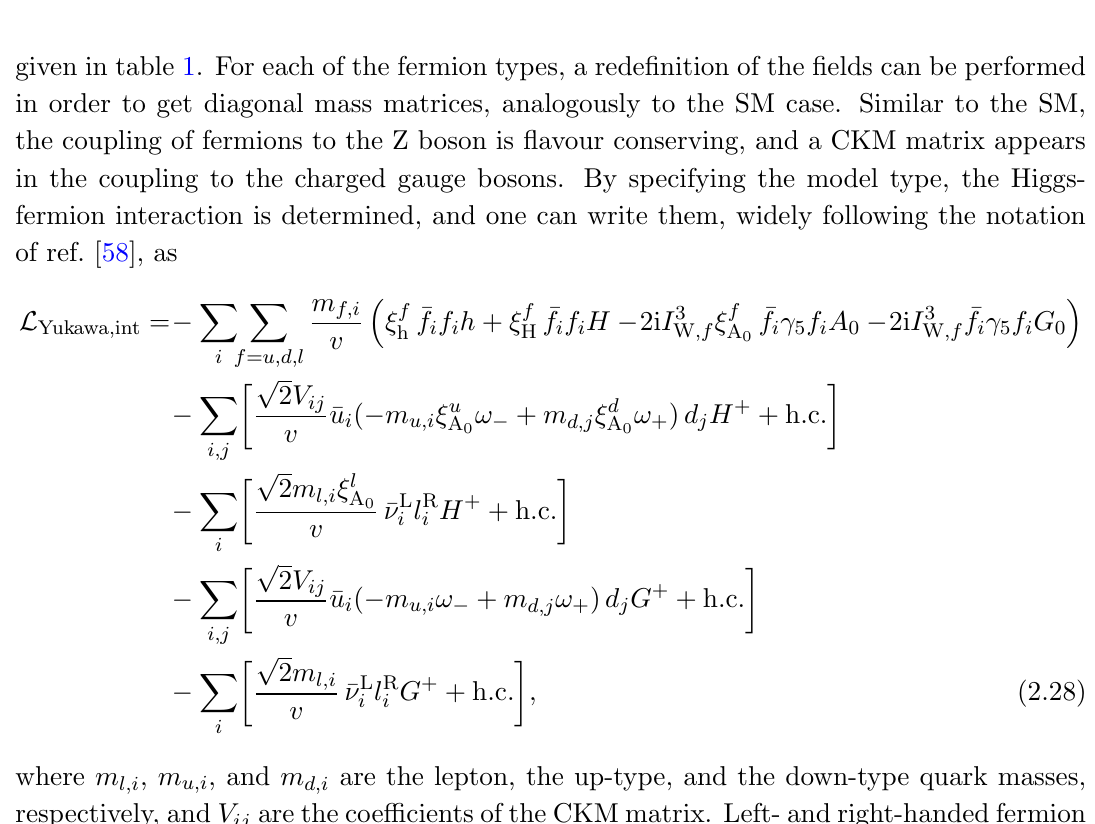
Table 1 . Di(cid:11)erent types of the THDM having in common that only one of the Higgs doublet couples to each type of fermions. This can be achieved by imposing appropriate Z 2 symmetry charges to the